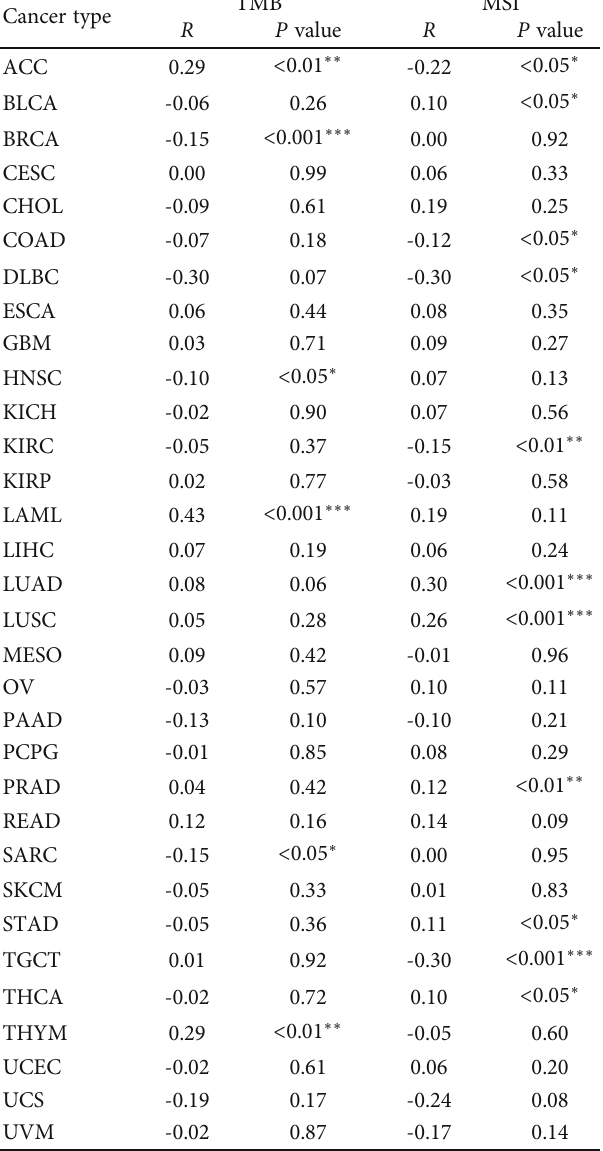
Table 2: Correlation between BACE1-AS expression and tumor mutation